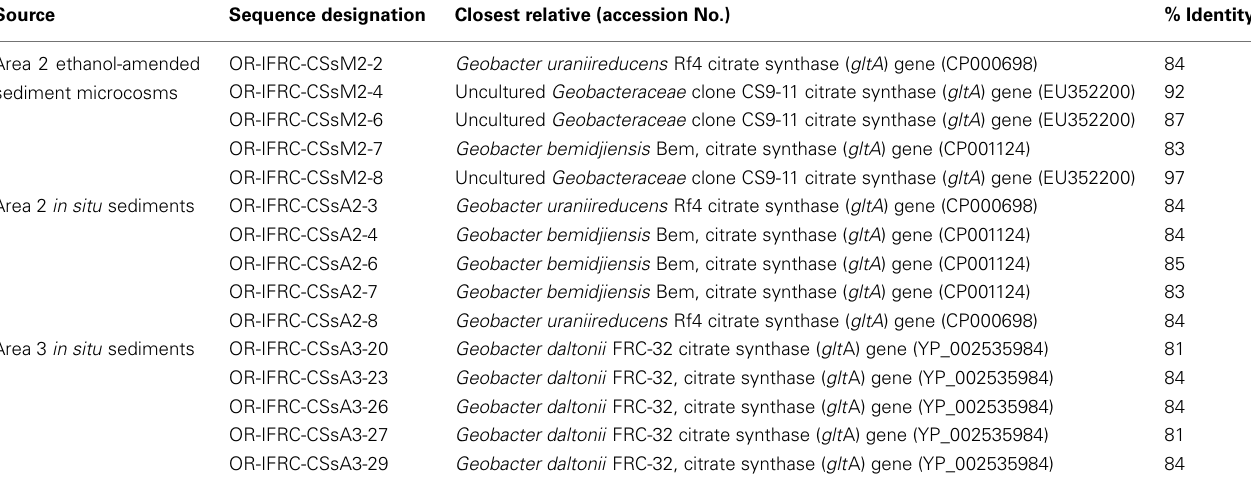
Table 3 | Partial glt A mRNA sequences retrieved from OR-IFRC ethanol-amended microcosms and in situ